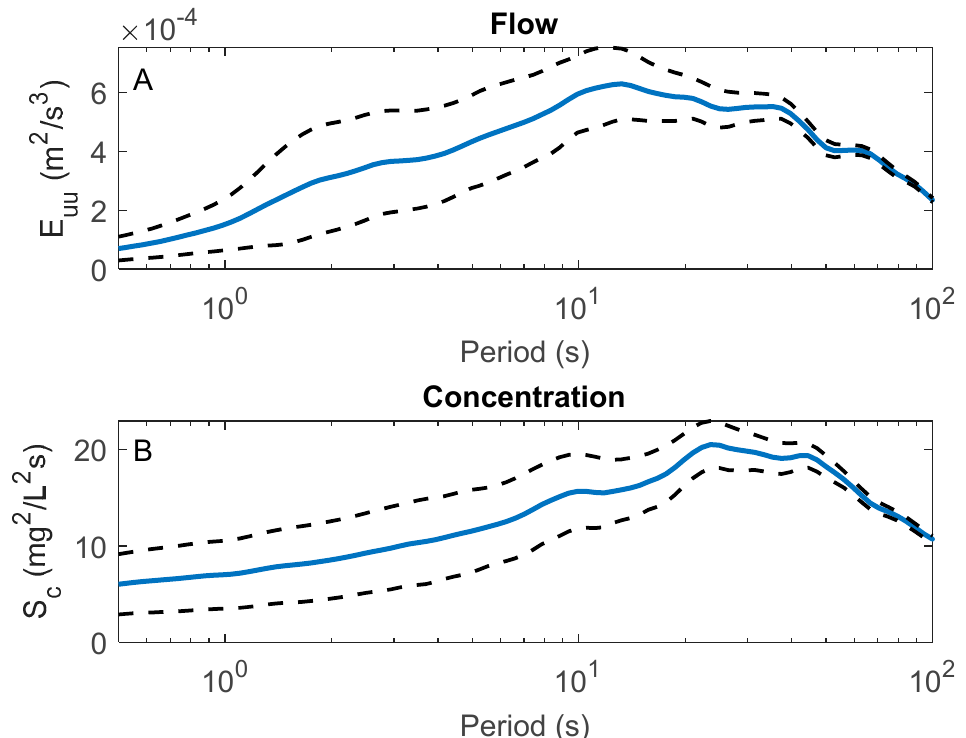
Figure 9. ( A ) Along channel energy ( E uu ) and ( B ) concentration spectrum ( S c ) averaged for all bursts, illustrating the persistence of localized peaks in the 8 to 32 s band. The dashed lines denote standard error.